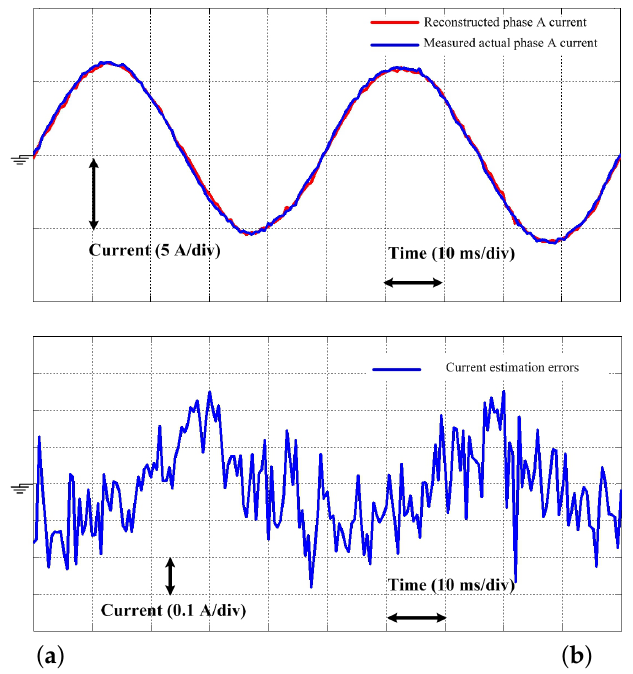
Figure 16. Reconstructed and actual measured phase A currents and the current estimation errors under the proposed method; time scale: 10 ms/div. ( a ) reconstructed and actual measured phase A currents; and ( b ) current estimation